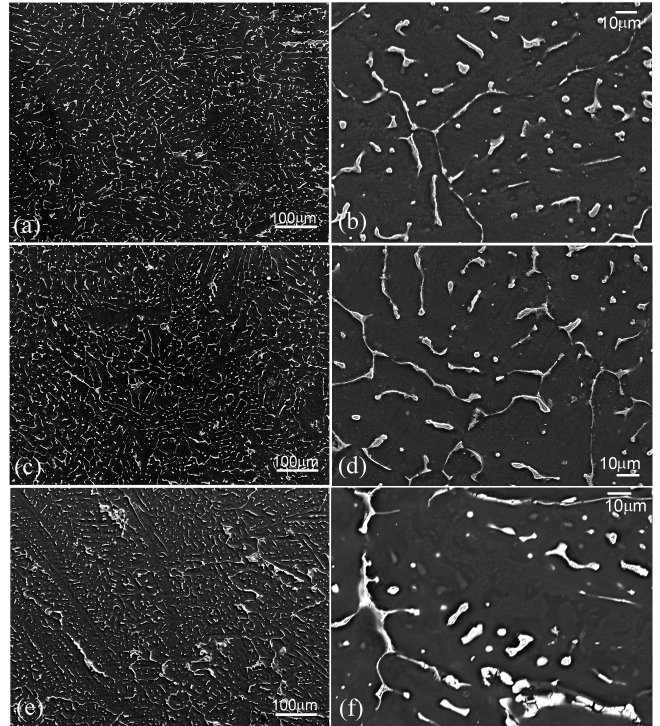
Figure 4. Solidification microstructure near the wall of the casting (100 cm up from the bottom), observed by SEM, for ( a , b ) Chill, ( c , d ) Conventional and ( e , f ) Water-cooled castings. ( b , d , f ) are higher magnification micrographs of ( a , c , e ),